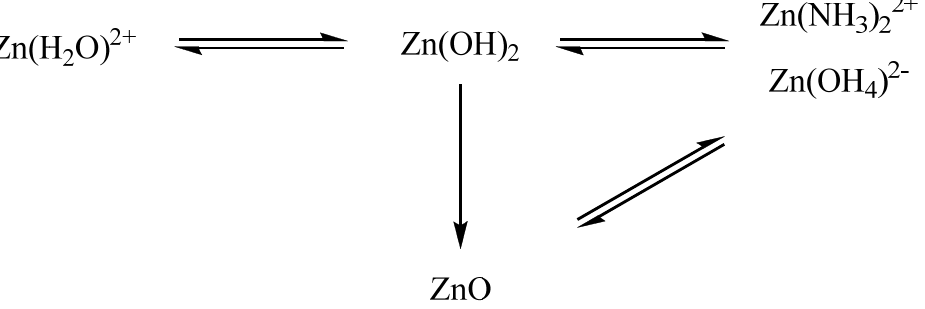
Figure 5. Scheme of chemical transformations occurring during the synthesis of complex ZnO gels.